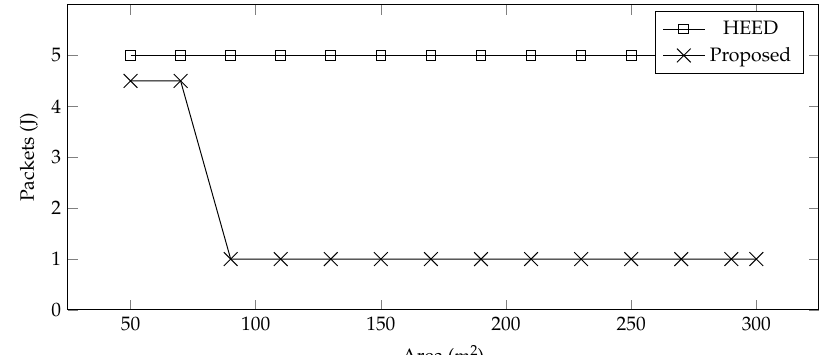
Figure 5. No. of Rounds vs. Control Packets.